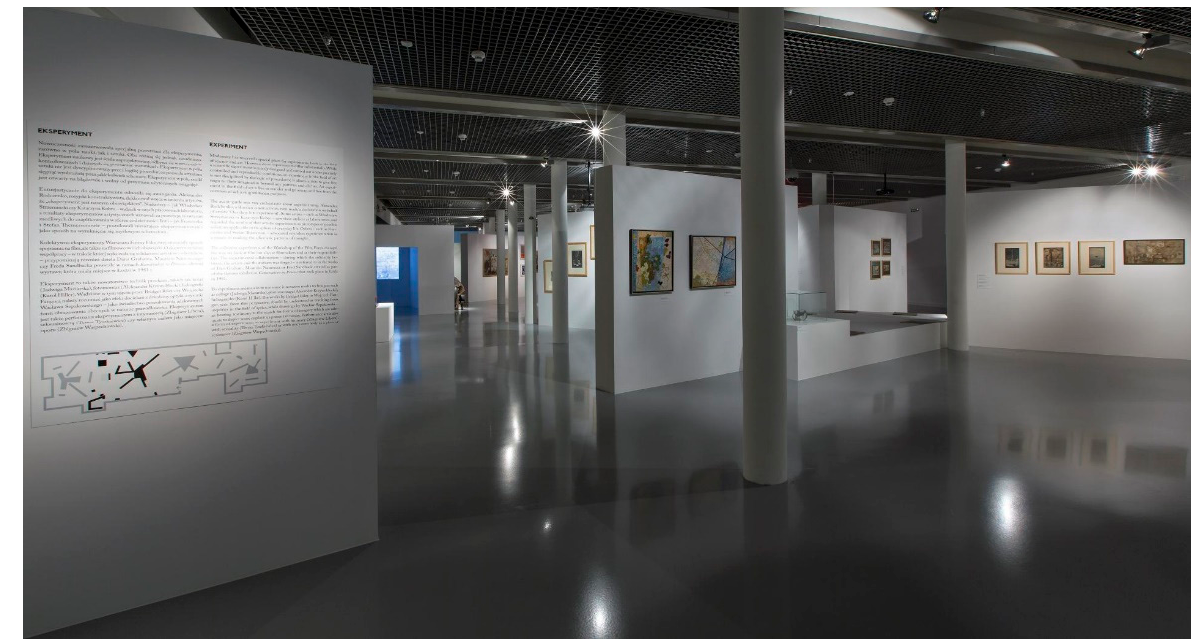
Figure 6. MS2 Art Museum in Ł ó d´z, documentation of the exhibition: Atlas of Modernity. The 20th and 21st Century Art Collection, MS2, 2014, photograph author: Piotr Tomczyk, source: the Resources of Art Museum in Ł ó d´z, available